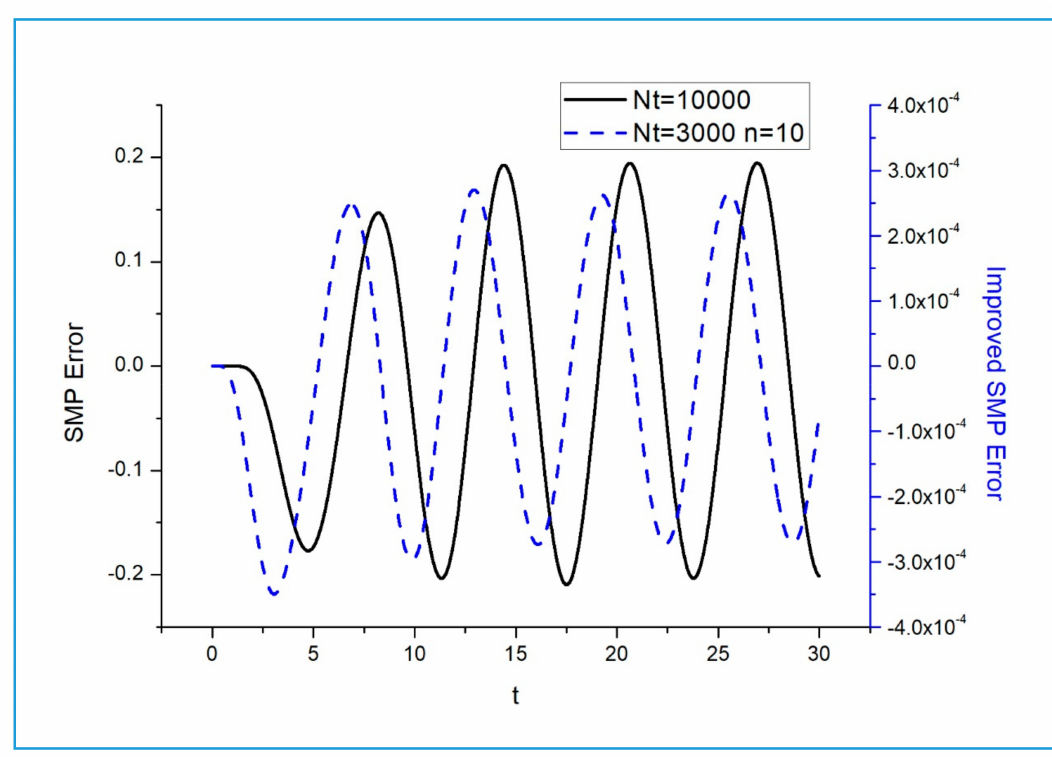
Figure 13. Error of the two SMP methods (SMP and improved SMP).